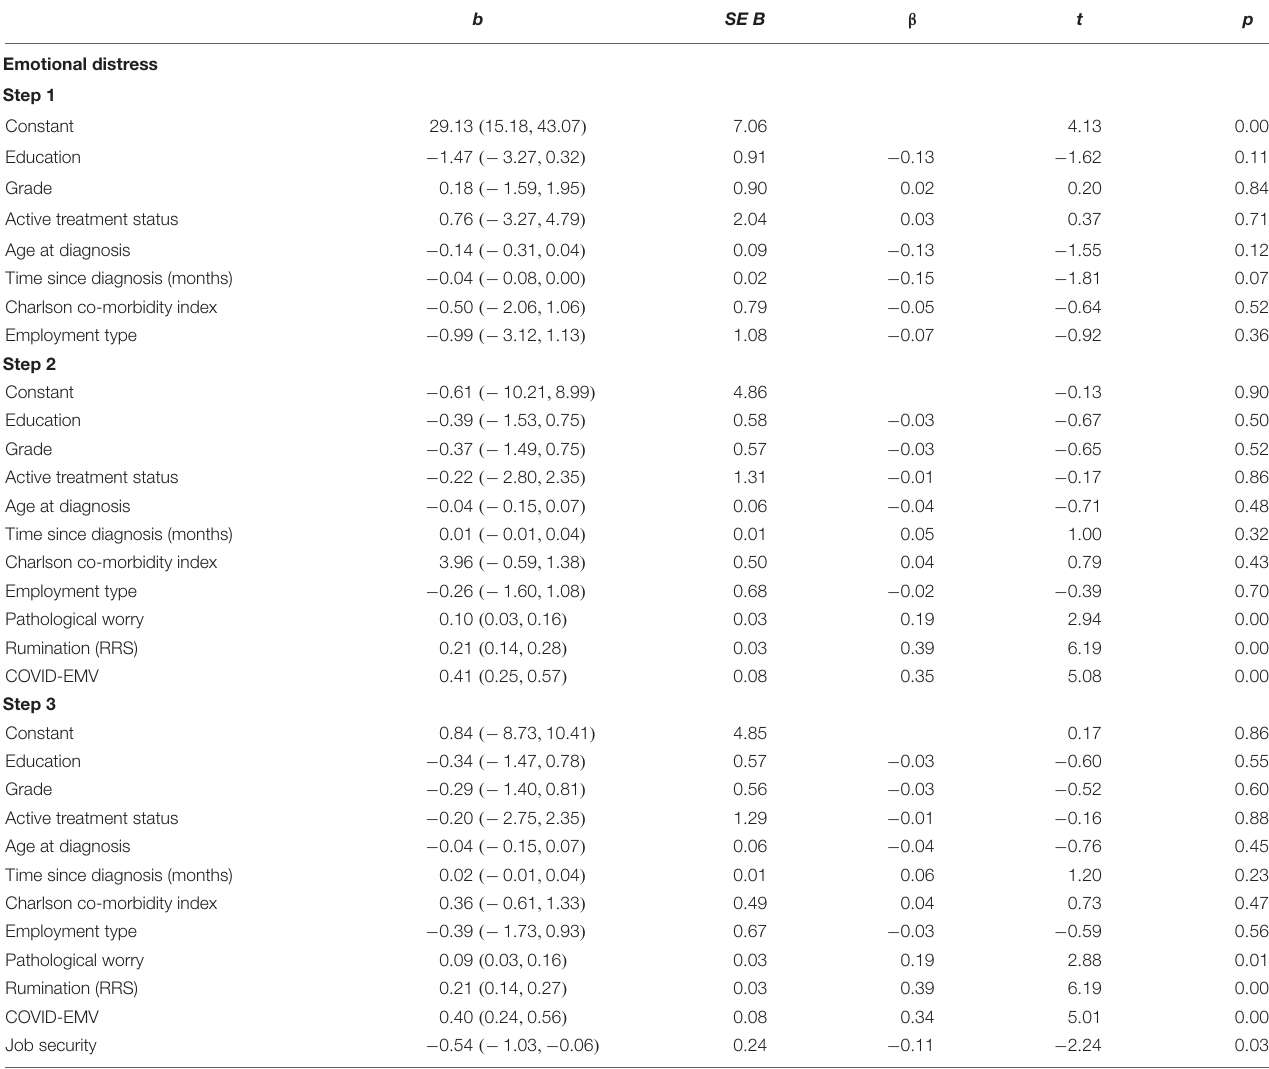
TABLE 5 | Hierarchical regression for the predictors of emotional distress (as measured by the HADS-total). b SE B β t